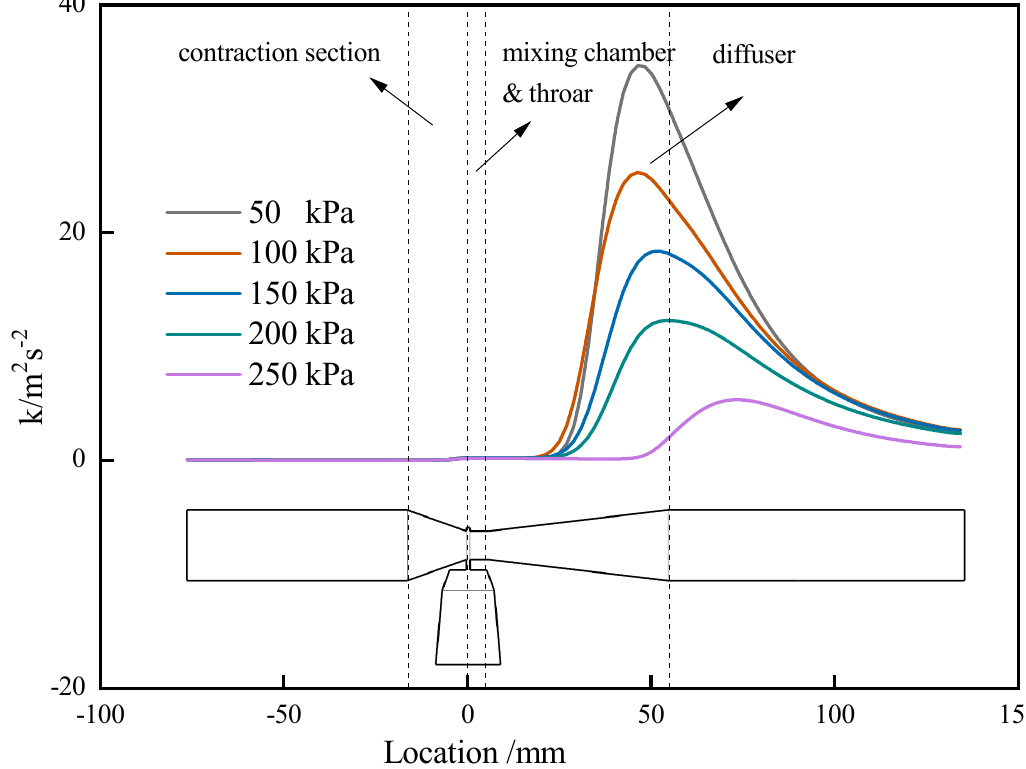
Figure 10. Turbulent kinetic energy at different outlet pressures.